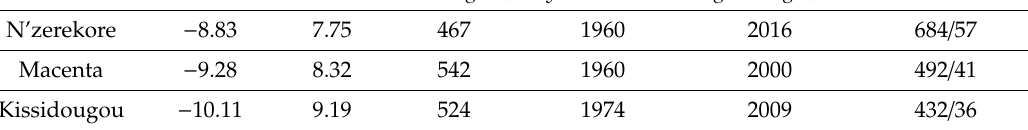
Forest Guinea: Forest and mountainous region; very watered with longest length; more